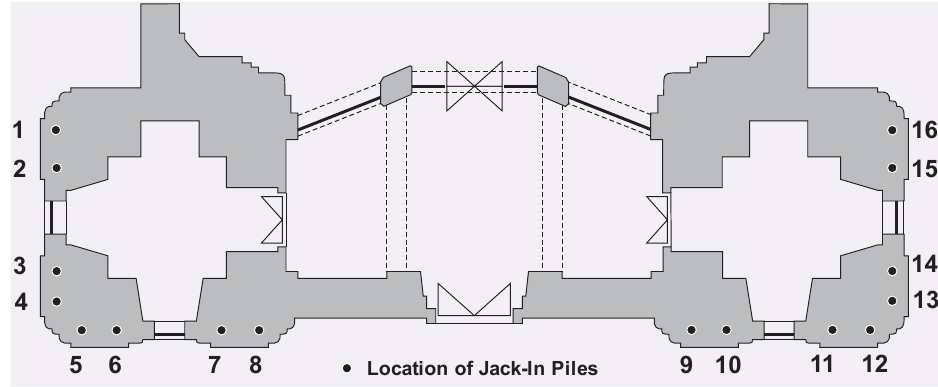
Figure 20. Layout of the piles below the foundations of the towers.